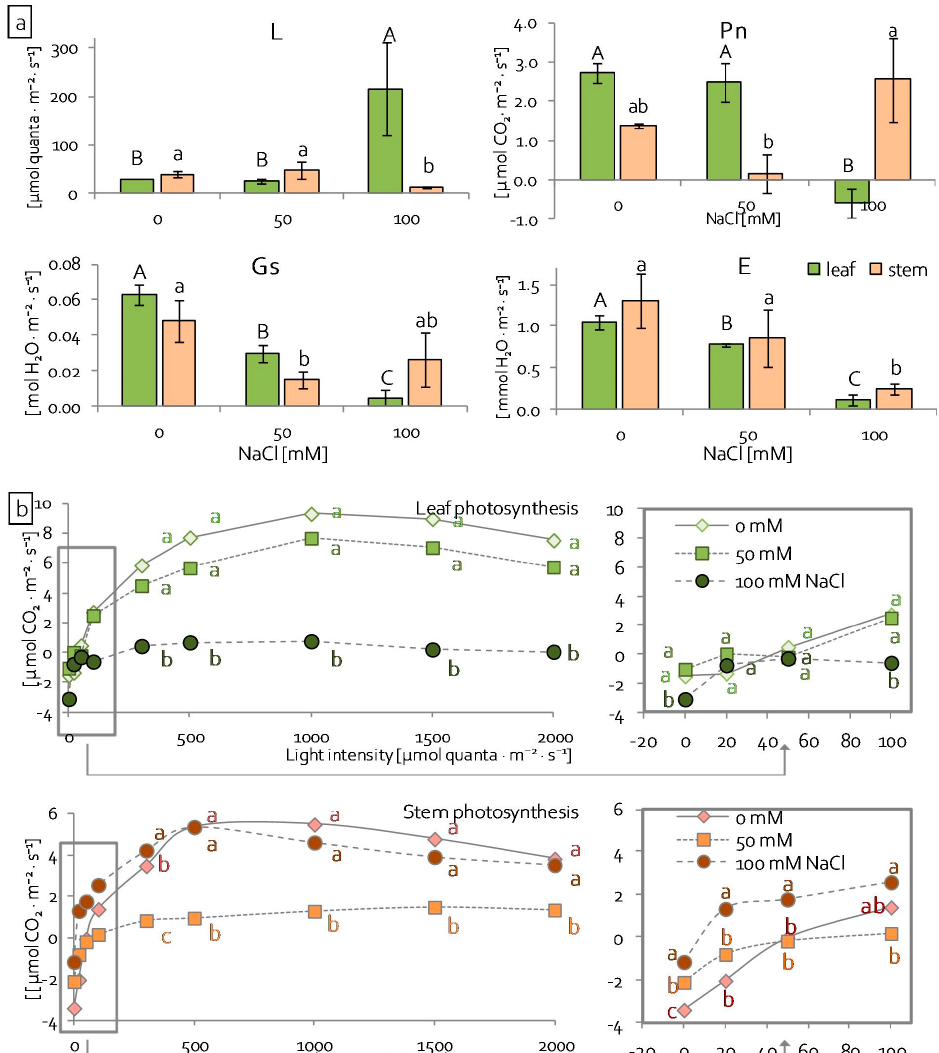
Figure 5. Efficiency of grass pea leaf and stem photosynthesis under salinity: ( a ) light compensation point (L), net photosynthesis (Pn), stomatal conductance (Gs), and transpiration (E) of leaves and stems at 100 μ mol quanta·m − 2 ·s − 1 ; ( b ) leaf and stem photosynthesis efficiency; different letters—statistically significant differences within each organ (leaf-uppercase, stem-lowercase) at p ≤ 0.05; ( n = 3).